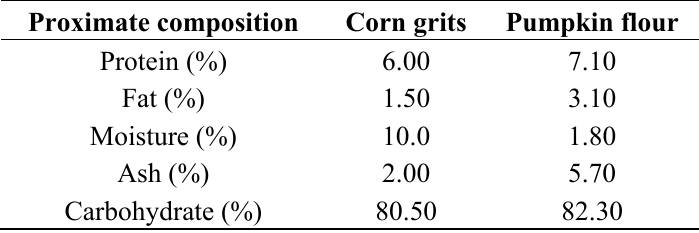
Table 1. Proximate composition of raw materials (corn grits and pumpkin flour) used for the extrusion.